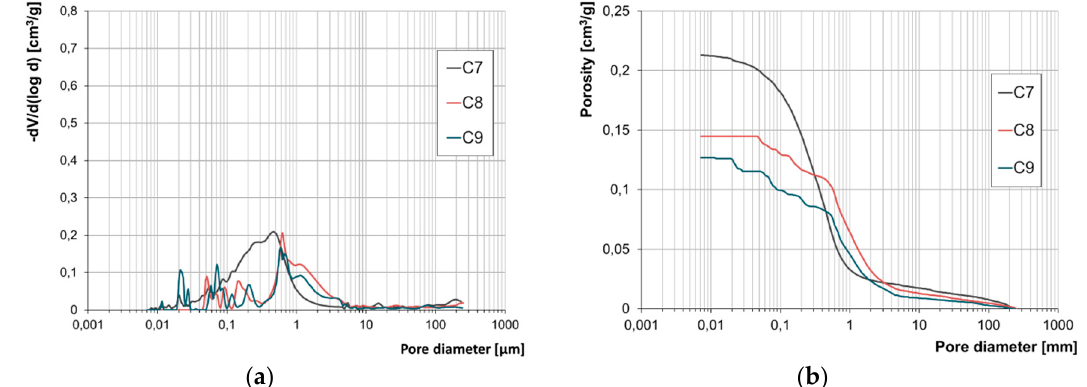
Figure 9. Pore size distribution ( a ) and cumulative curves of pores volume distribution ( b ) for cracking bricks C7, C8 and C9.